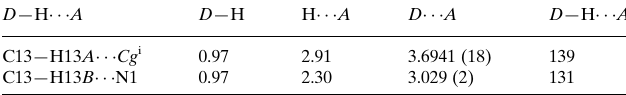
Hydrogen-bond geometry (A˚ , (cid:2) ). Cg is the centroid of the C7–C12 benzene